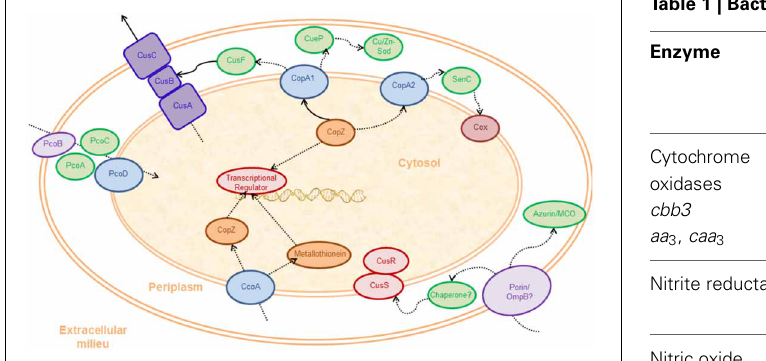
FIGURE 1 | Scheme of systems participating in Cu + homeostasis in a Gram-negative bacterial cell. The drawing represents the major systems, and not all cuproenzymes are depicted. Various bacteria contain different subsets of these molecules (Hernández-Montes et al., 2012). Experimentally verified Cu + transfer and transport events are indicated with solid lines. Postulated Cu + fluxes are indicated with dotted lines. The colored shapes represent groups of proteins (various transcriptional regulators, various chaperones, etc.): putative outer membrane transporters (lavender), periplasmic Cu + chaperones and cuproenzymes (green), membrane cuproenzymes (magenta), Cus system (royal blue), inner membrane transporters (purple), transcriptional regulators (red), cytosolic Cu + chaperones (orange).